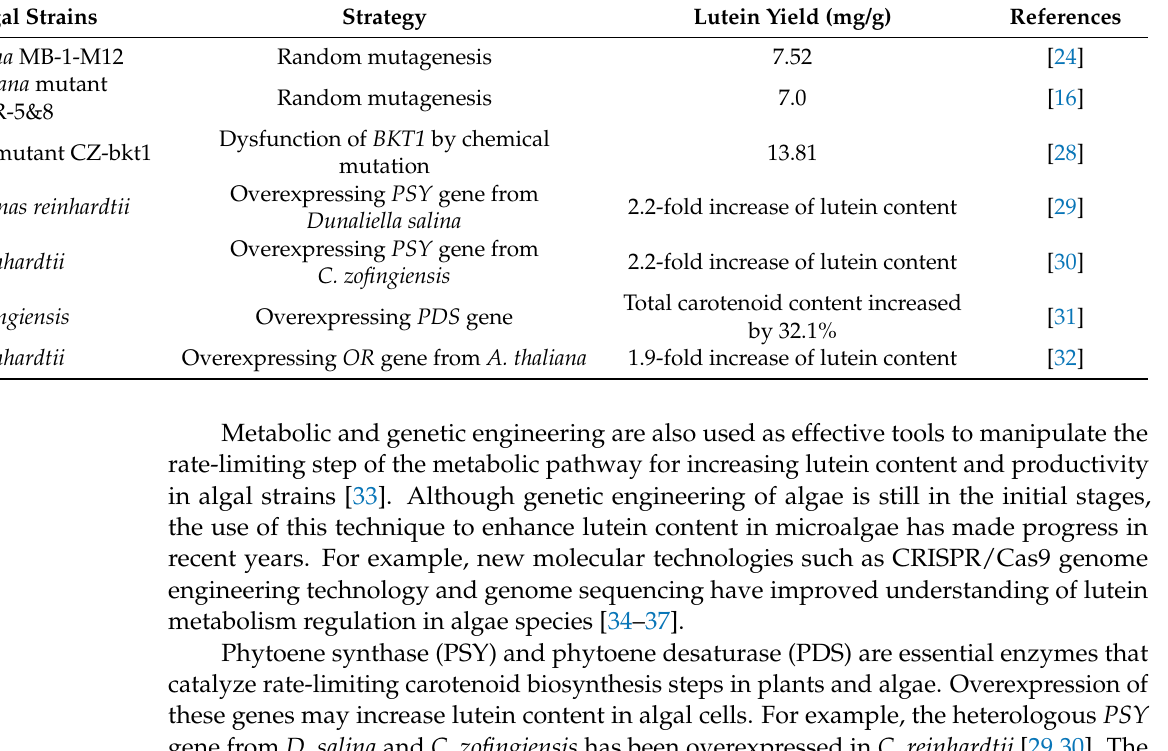
Table 2. Examples of mutagenesis and metabolic engineering strategies for altering lutein content in microalgae strains. Microalgal